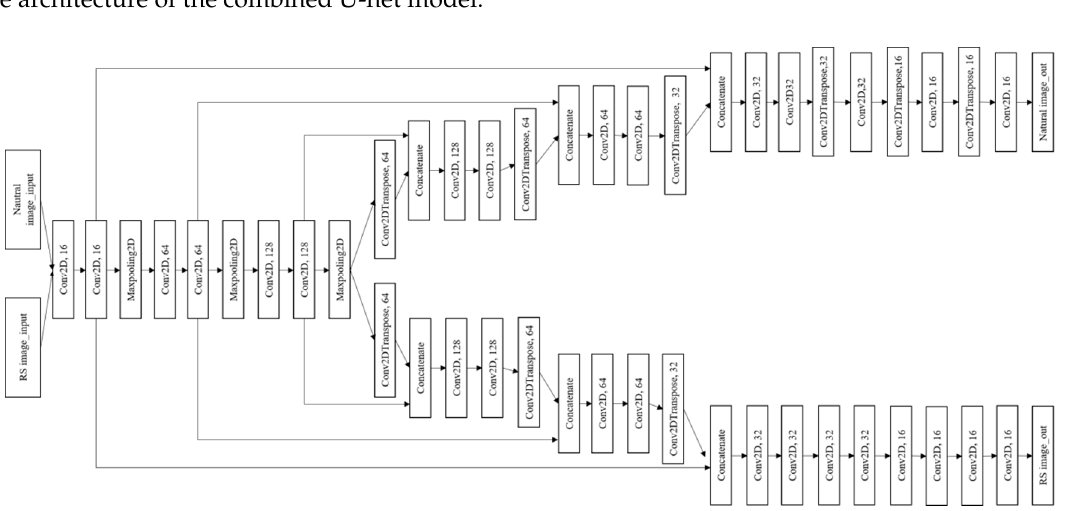
Figure 1. Architecture of the combined U-net model. “Conv2D” denotes the two-dimensional (2D) convolutional layers, and “Conv2DTranspose” denotes a transposed 2D convolutional layer. “Concatenate” denotes a concatenated layer.